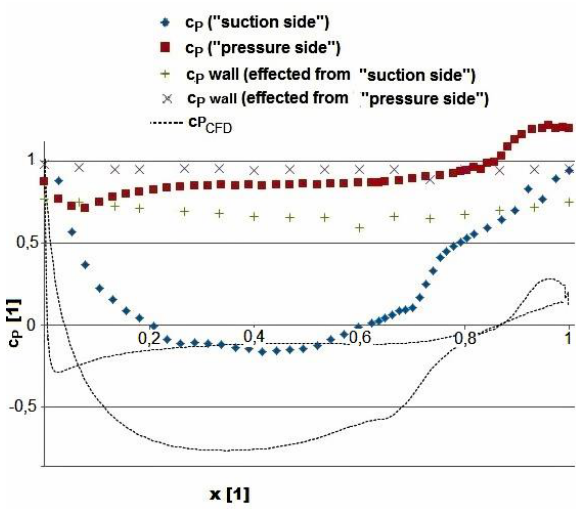
Fig. 4. Pressure coefficient c P for suction side c PH and pressure side c PD of the airfoil AH93-157 and pressure coefficient c PW on the corresponding walls. Experimental and preliminary CFD results, angle of attack α = 0 deg. The flow separation is good recognizable.